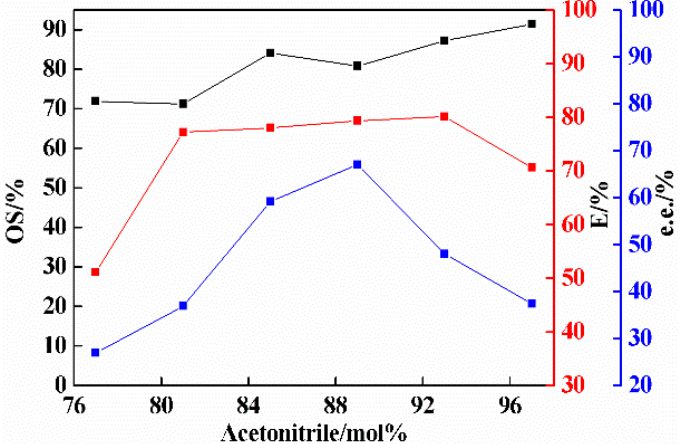
Figure 4. Effect of solvent amount on the resolution of 3-ClMA by LEV (the mole fraction of acetonitrile refers to the ratio of the moles of acetonitrile to the sum of the moles of acetonitrile and raw materials, mol%) [37,46]. (LEV = 2.84 mmol; 3-ClMA = 2.32 mmol; crystallization temperature = − 15 °C; equilibrium time = 12 days).